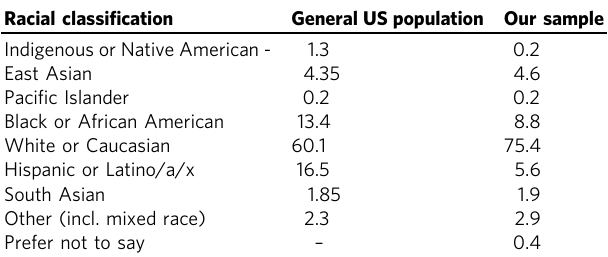
Table 2 Racial diversity of US population vs. our